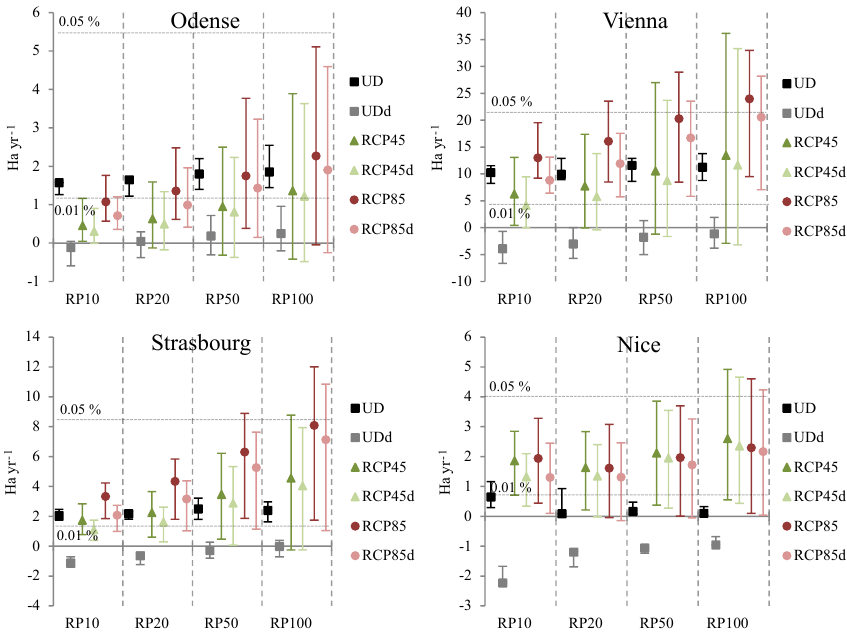
Figure 8. Averaged annual change in the total flooded area (greater than 10cm water depth) due to the impacts of urban development (UD) and climate change (RCP 4.5 and RCP 8.5) on extreme precipitation for different return periods (RP 10–RP 100). UDd represents the drainage system updated to follow changes in imperviousness caused by urban development. RCP 45d and RCP 85d represent the drainage system updated to follow changes in precipitation intensities caused by climate change. Error bars represent low/high infiltration rates and low/high climate factors (CFs) respectively (low CF is in the 10th percentile and high CF is in the 90th percentile). The horizontal percentage lines highlight the share of total urban area for each city. Please note the differences in unit (ha) on the y axis compared to Fig. 7 (km 2 ).